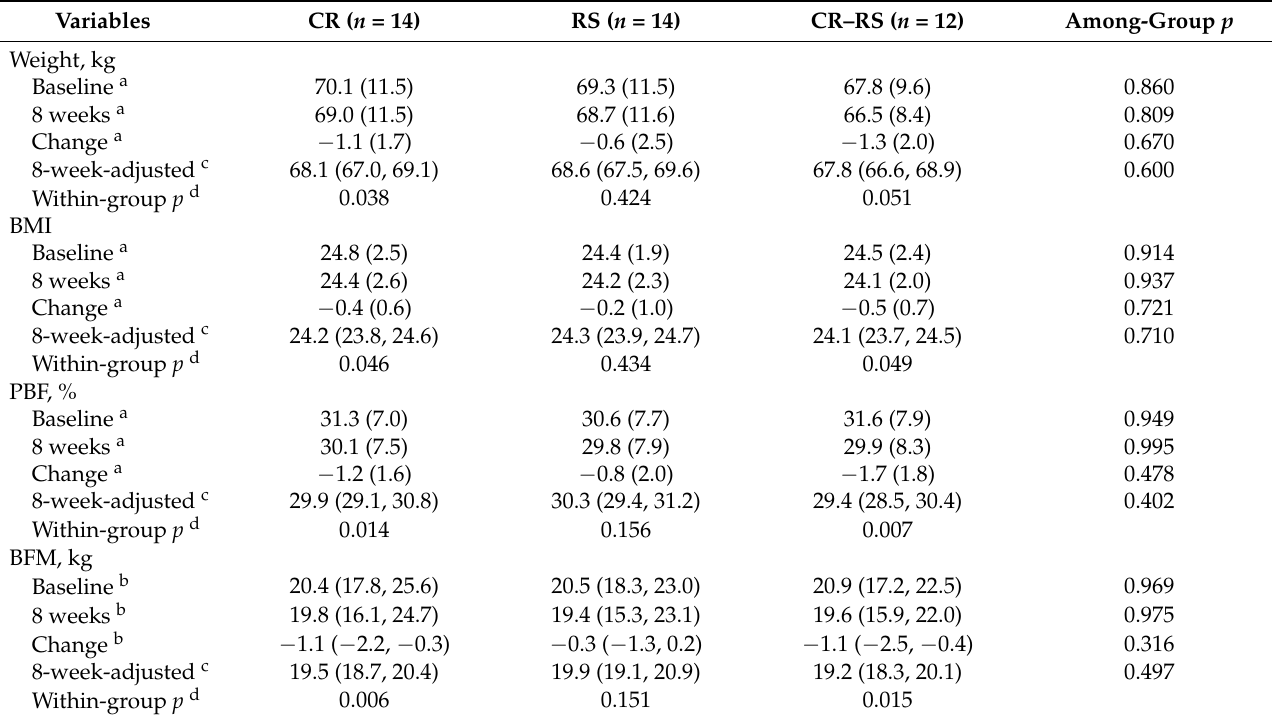
Table 2. Intervention effects on body weight and